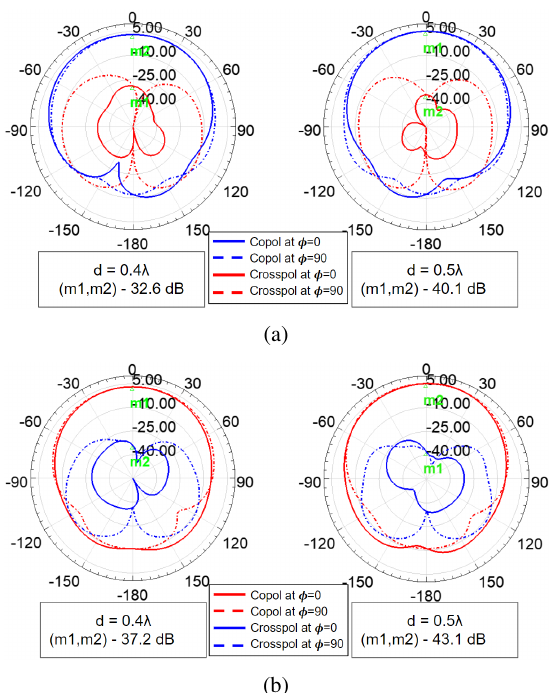
FIGURE 12: Active element patterns for 0.4 λ and 0.5 λ spacing for (a) H and (b) V polar